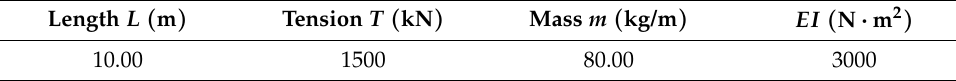
Table 1. Parameters of cable for theoretical